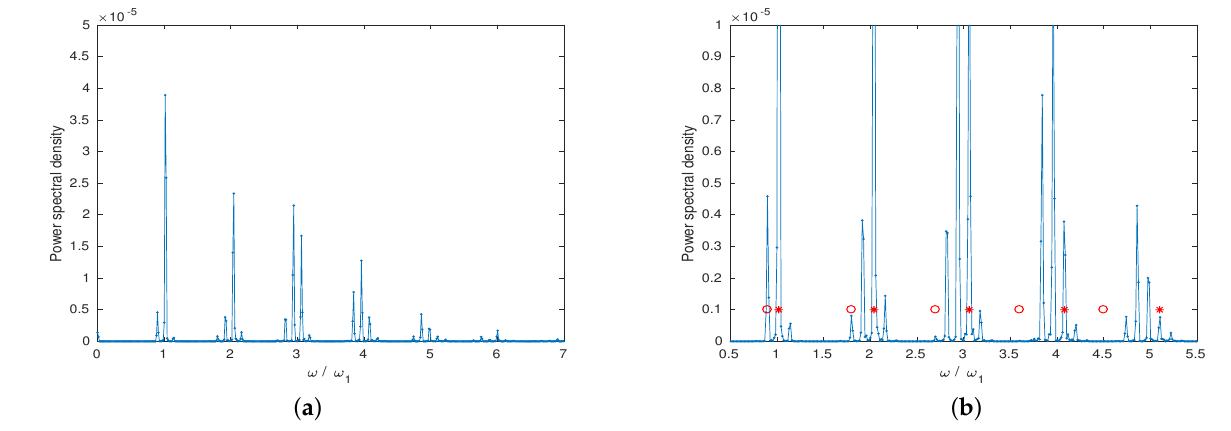
Figure 11. The frequency spectrum of coupled sway and roll cases under different excitation fre- quencies. excitation frequency: ( a ) ω / ω 1 = 1.02, excitation amplitude : 0.001 m (sway); excitation frequency : ω / ω 1 = 0.90, excitation amplitude : 0.001 rad (roll); ( b ) integer multiple.